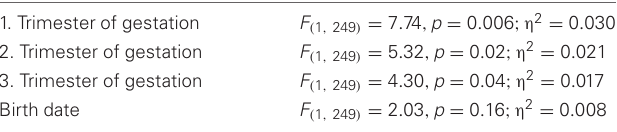
Table 2 | Decline of the interaction effect gene by solar activity from the first trimester to birth on left hippocampus volume ( η 2 are partial η 2 ).